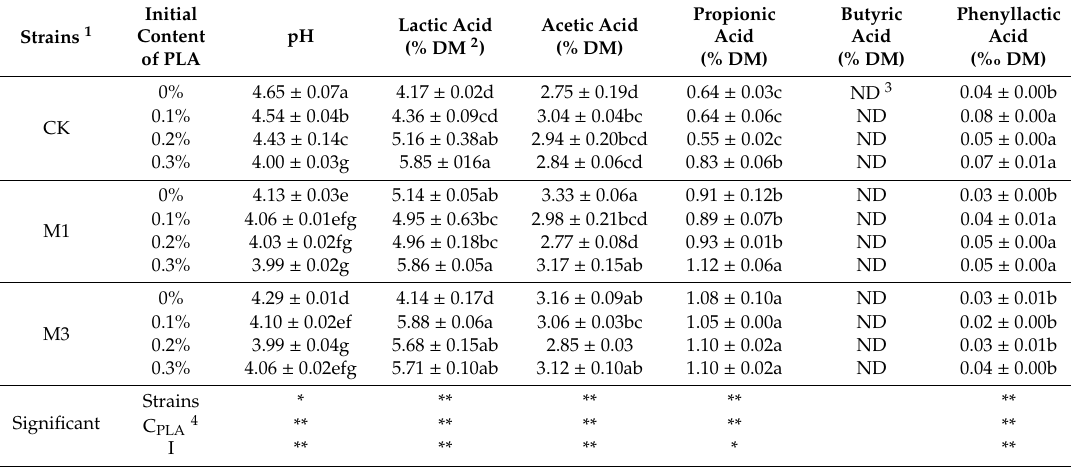
Table 3. E ff ect of lactobacillus bacteria and phenyllactic acid on the fermentation characters of alfalfa